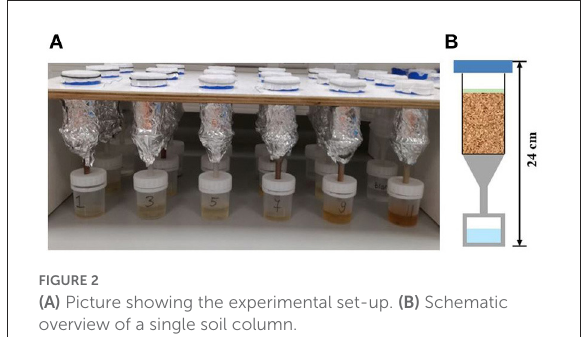
FIGURE2 (A) Picture showing the experimental set-up. (B) Schematic overview of a single soil column.